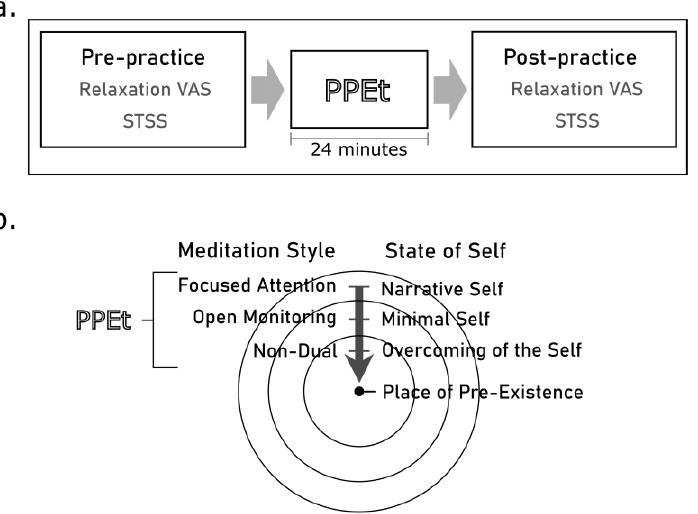
Figure 2. ( a ) Experimental protocol. A measurement for relaxation on a visual analogue scale (relaxation VAS) and items from the Subjective Space Time and Self inventory (STSS) were collected before and after 24 min of practice of Place of Pre-Existence technique (PPEt). ( b ) Layout of the PPEt practice showing the progressive steps involving different styles of meditation (left) required to promote the transition across selves (right) towards the Place of Pre-Existence.